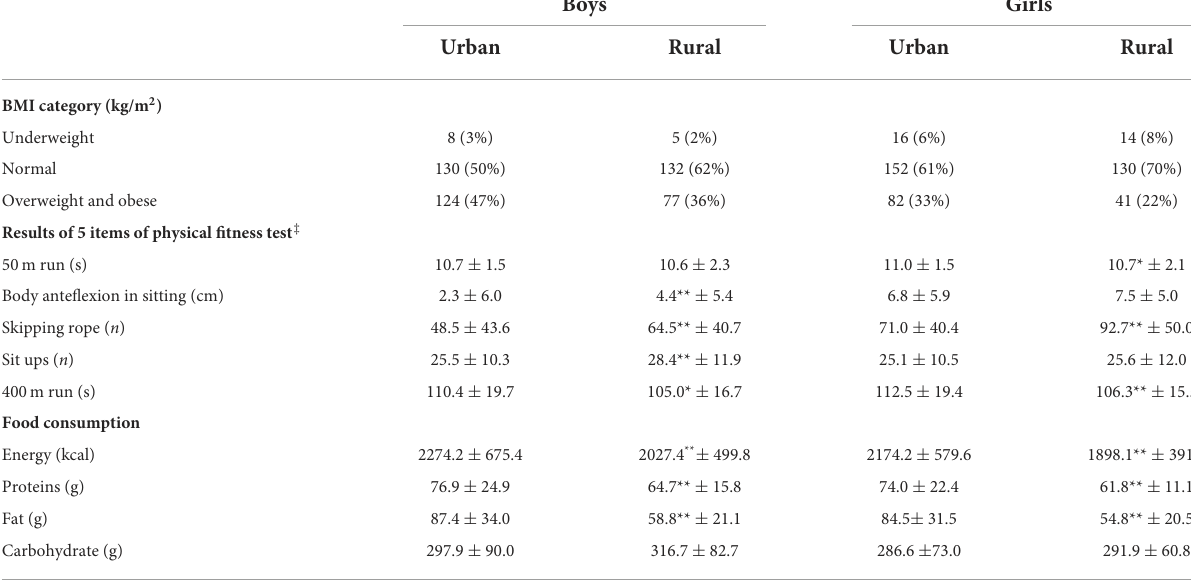
TABLE 1 BMI category, 5 items of physical fitness and food consumption for urban and rural children † . Boys Girls Urban Rural Urban